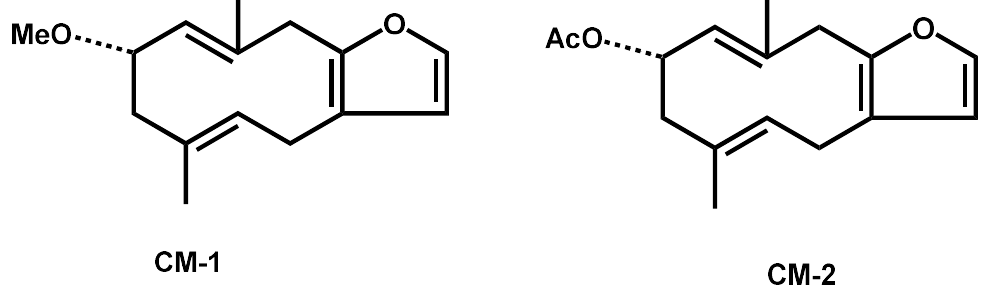
Figure 1. Chemical structures of 2-methoxyfuranodiene (left) and 2-acetoxyfuranodiene (right) isolated from the chloroform fraction of C.